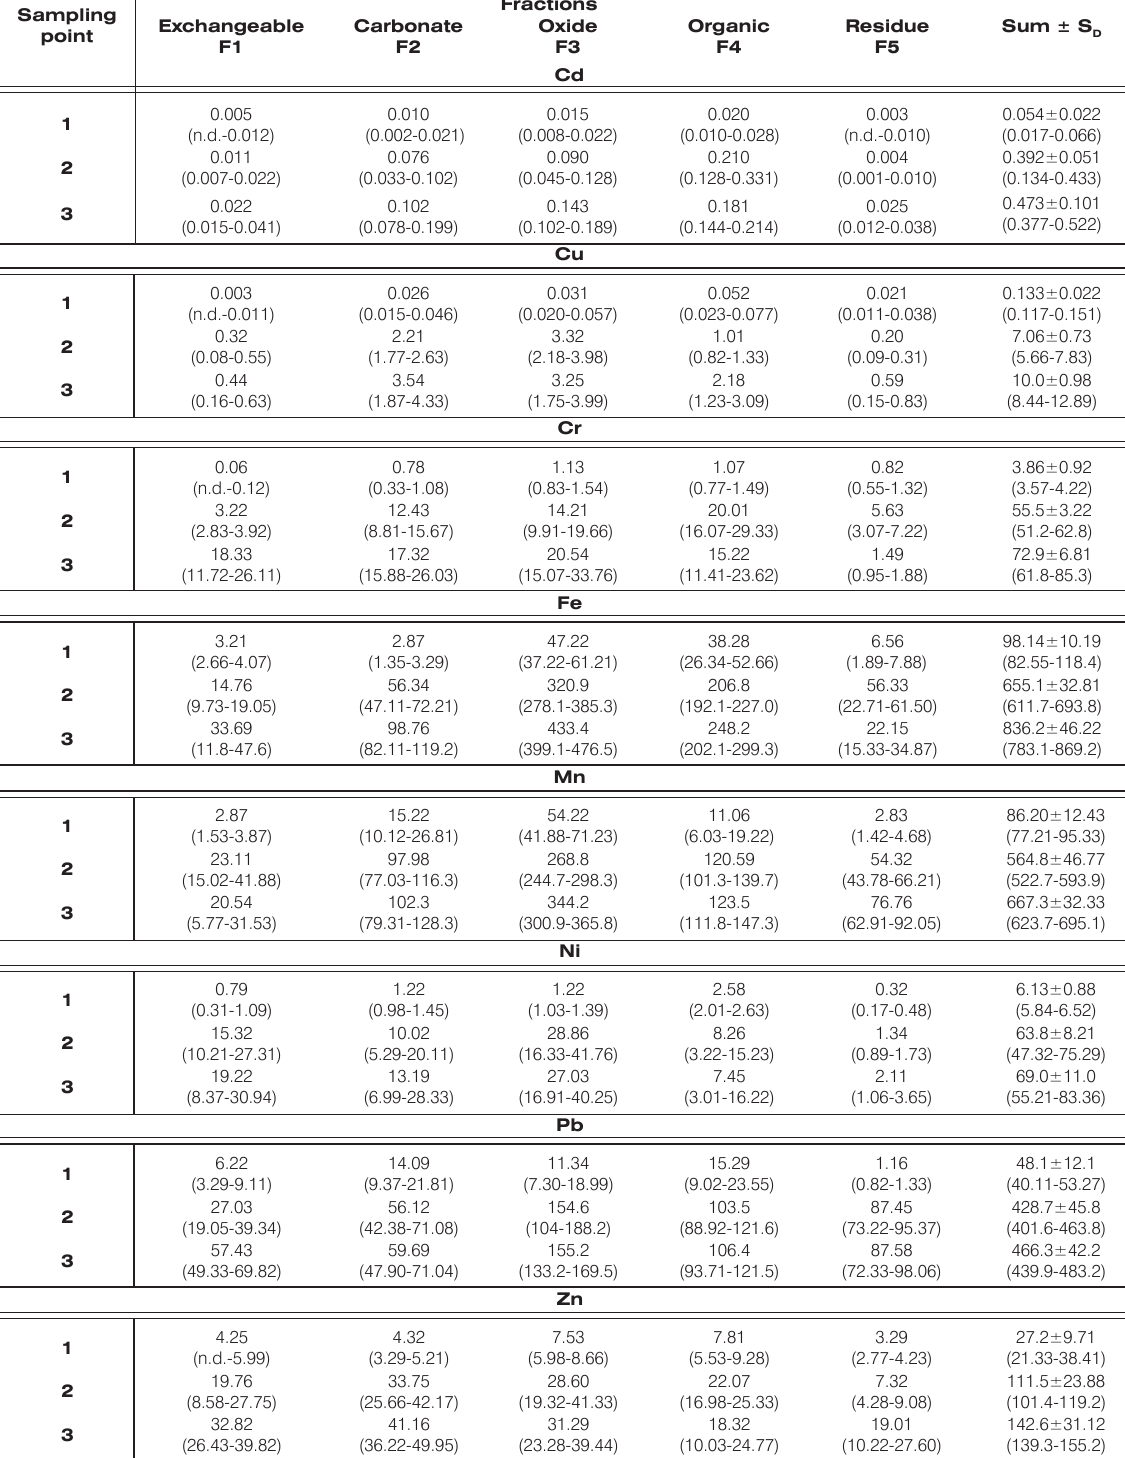
Table 3. Average content (and min-max) of heavy metals (Fe, Mn, Cd, Pb, Zn, Cr, Cu, Ni) in Bobrza River sediment samples, and its distribution in particular fractions between April 2009 and April 2010 at particular sites [mg kg -1 dry matter] ( n ≥ 39). Sampling